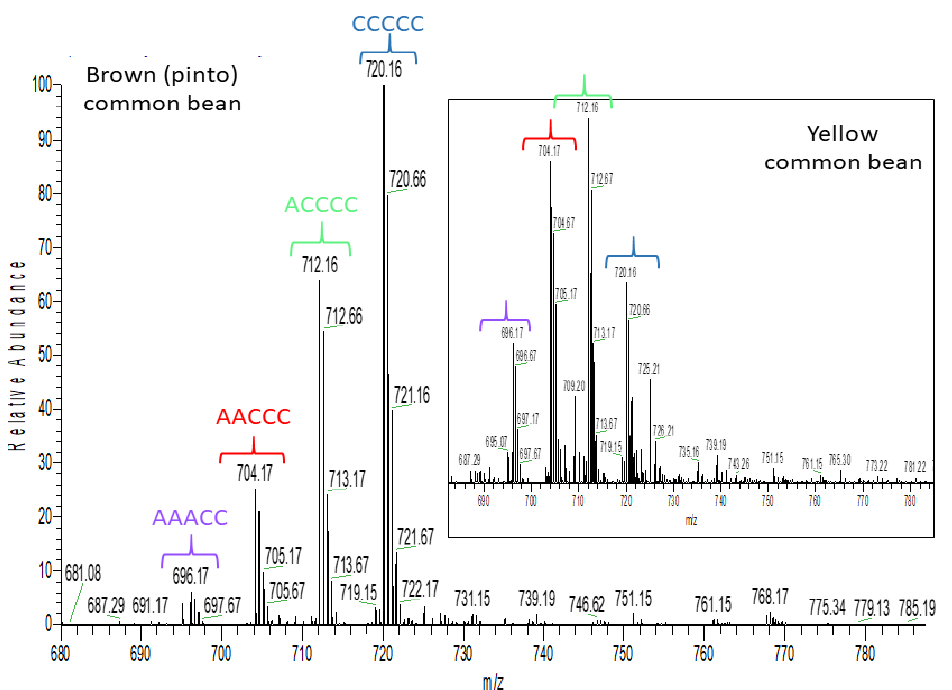
Figure 6. High resolution mass spectrometric (HRMS) full scan showing a procyanidin pentamer and different propelargonidin pentamers detected in yellow and brown common bean seed coats. Brackets with the same color have the same pentamer structure. C: (epi)catechin and A: (epi)afzelechin.